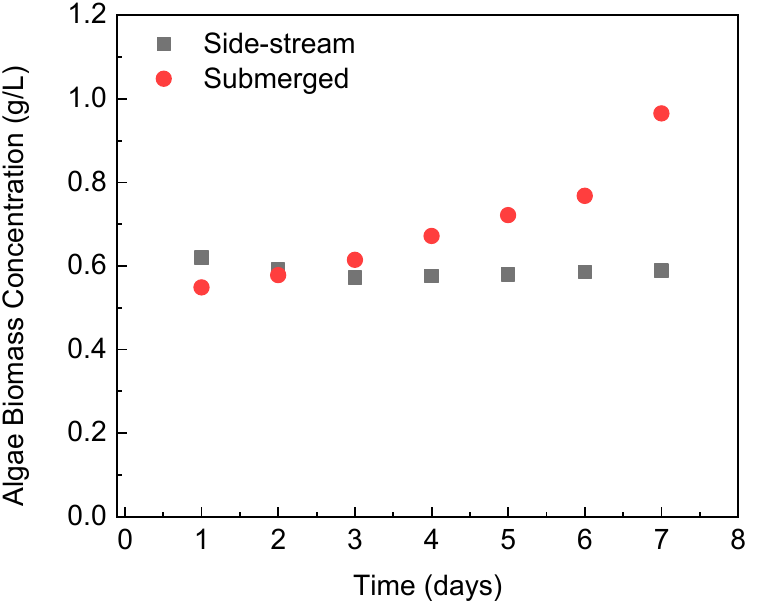
Figure 3. Algae biomass concentration in the PBR with different FO configurations during semi- continuous operation.